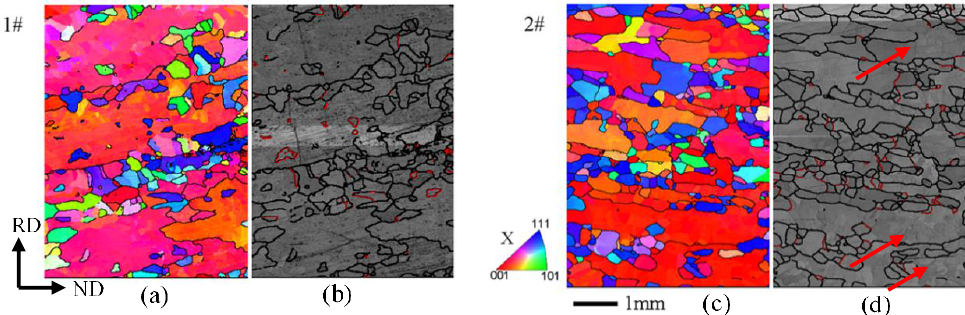
Figure 2. EBSD maps of 1# (1%Si) and 2# (0.72%Si) cast slabs. ( a , c ) IPF-ND map and ( b , d ) band contrast maps with grain boundaries characters (red: Σ3).